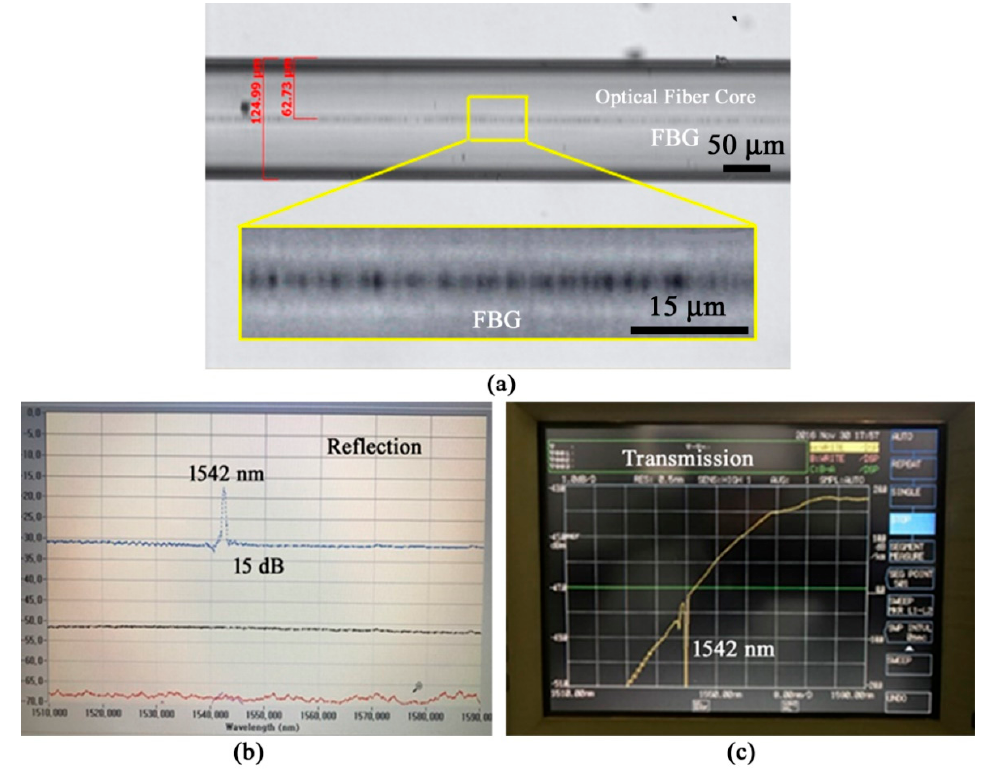
Figure 5. Characteristics of the FBGs fabricated inside the fiber core. ( a ) Image of the FBGs; ( b ) reflected signal from the FBGs at the Bragg wavelength of 1542 nm; ( c ) transmission spectrum of the FBG-incorporated optical fiber.